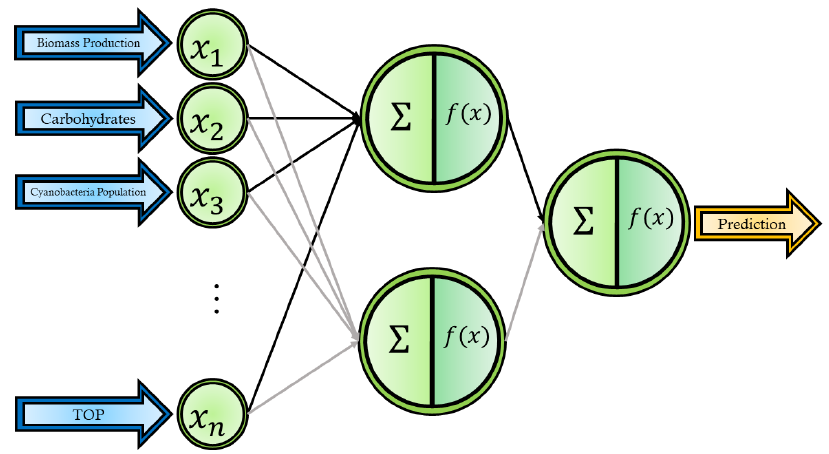
Figure 2. Artificial Neural Network scheme applied for the regression task.